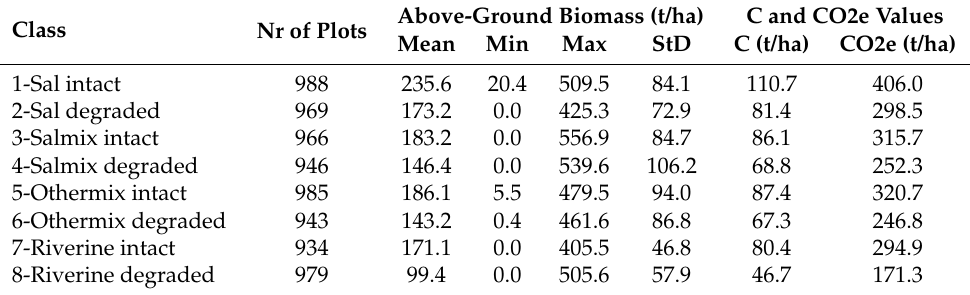
Table 3. Statistics of the forest class- specific estimations for above-ground biomass, mean carbon density and carbon dioxide equivalent CO2e (t/ha).